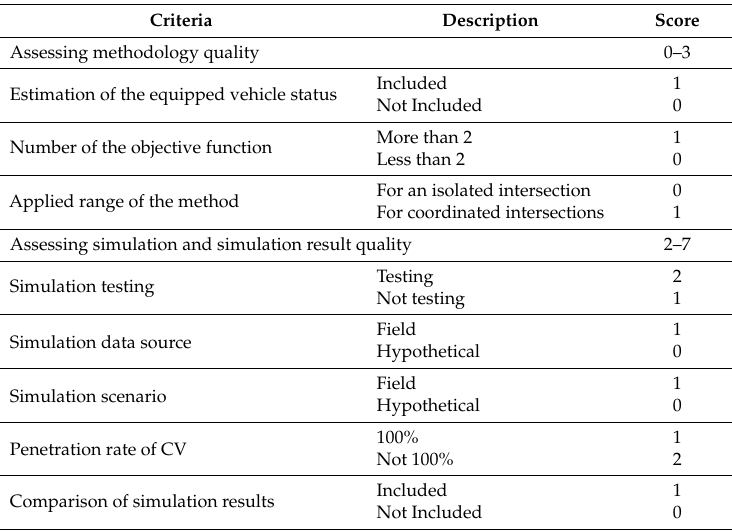
Table 1. Checklist for evaluating studies’